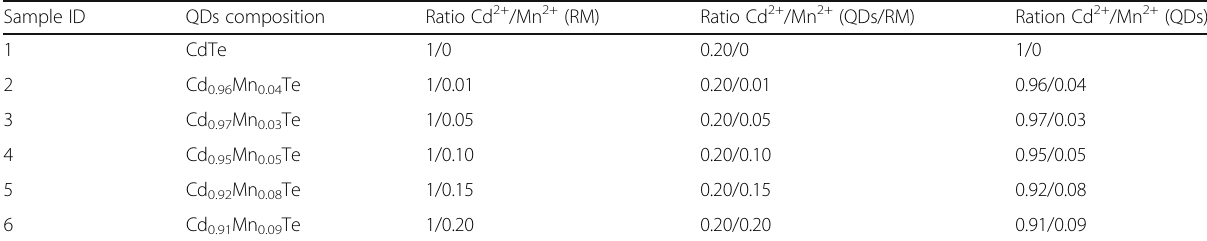
Table 1 The Cd 2+ /Mn 2+ ratio in the reaction mixtures (RM) and in the QDs as determined by AES measurements Sample